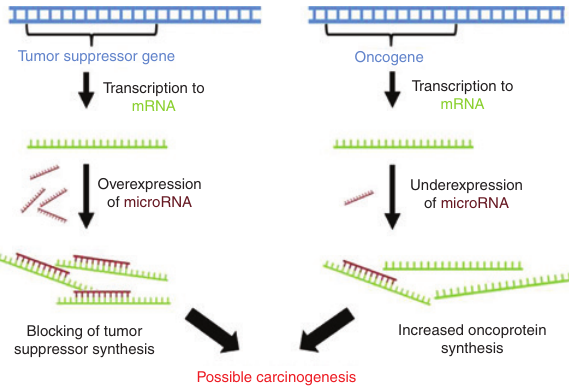
Figure 4: Two alternative routes to carcinogenesis involving microRNA deregulation. (Left) Overexpression of miRNA regulating tumor suppressor gene leads to its decreased expression, result- ing in fewer tumor suppressor proteins to protect the cell. (Right) Downregulated expression of miRNA regulating oncogene (i.e. gene coding an oncoprotein, which supports cell proliferation and division) is not present in sufficient amounts, and thus increased number of oncoproteins is